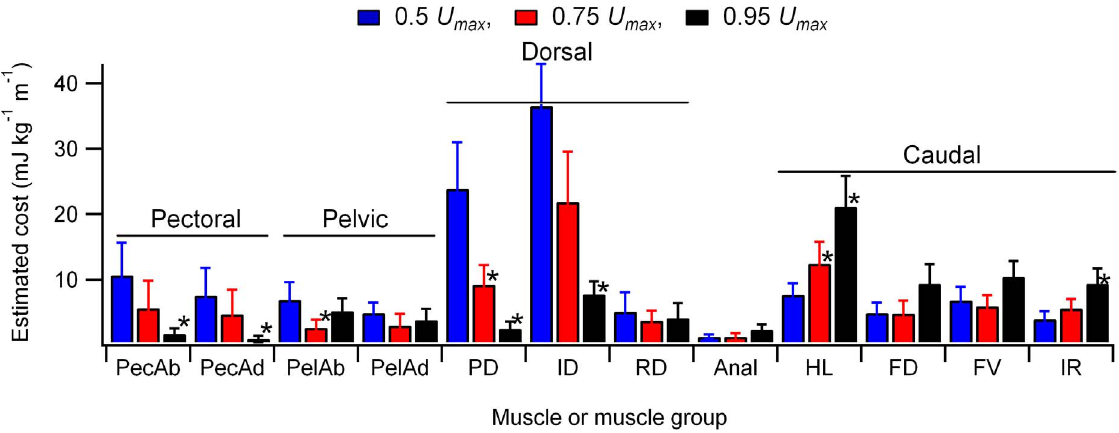
Figure 5. Estimated energy costs of activity within the fin musculature. Energy estimates were obtained by multiplying the total estimated energy directed to the fin muscles, expressed as a net cost of transport, by the proportion of fin muscle blood flow received by each muscle or muscle group. Data are shown as mean 6 sem (N=6 to 8). * designates a significant change relative to the adjacent lower speed condition. Muscles are as follows: PecAb, pectoral fin abductors; PecAd, pectoral fin adductors; PelAb, pelvic fin abductors; PelAd, pelvic fin abductors; PD, protractor dorsalis; ID, inclinator dorsalis; RD, retractor dorsalis; Anal, anal fin musculature; HL, hypochordal longitudinalis;FD, flexor caudalis dorsalis; FV, flexor caudalis ventralis; IR, interfilamenti caudalis.